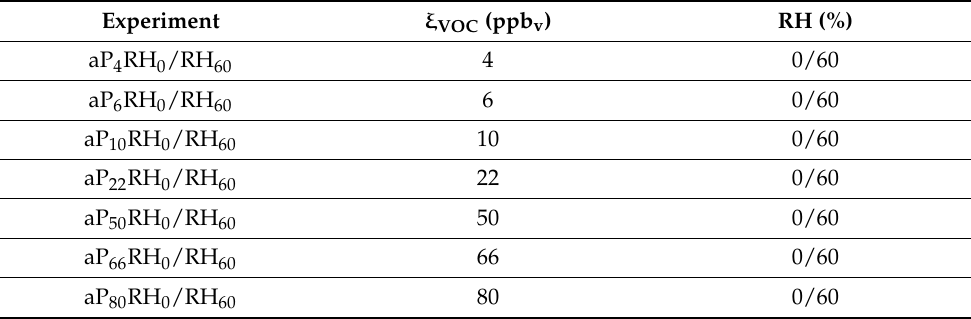
Table 1. Parameters for all NPF chamber experiments reported herein pertaining to α -pinene. In all cases, chamber temperature was 20 ( ± 1) ◦ C.